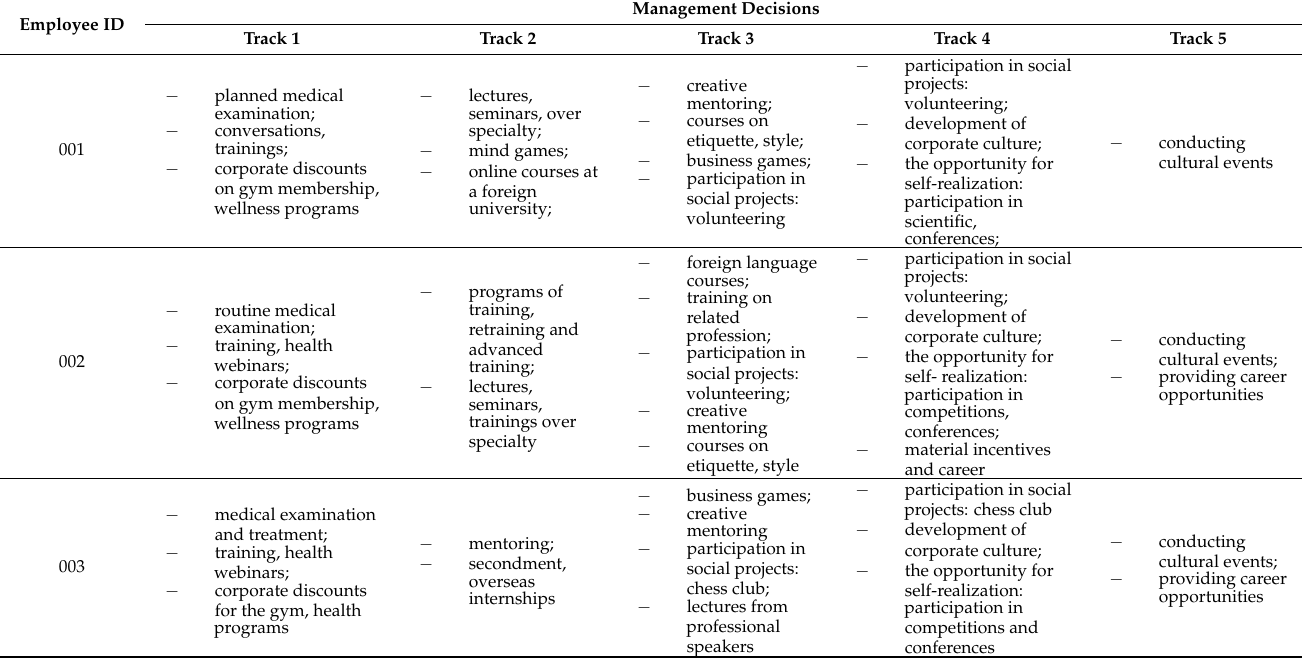
Management Decisions